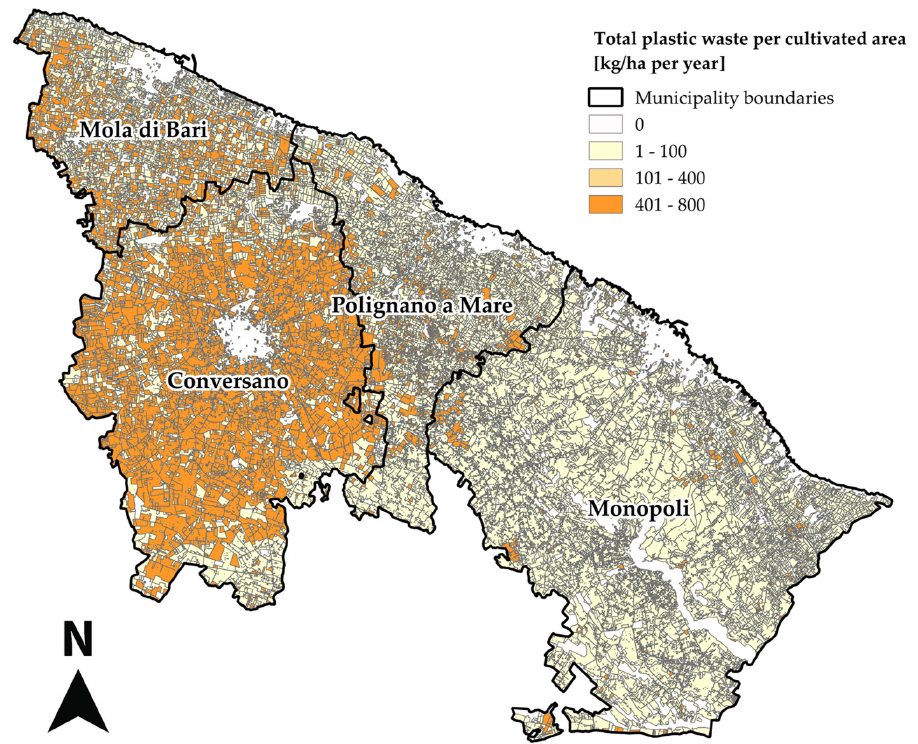
Figure 6. Distribution of the total APW in the four municipalities in the case of combination of the two improved scenarios (scenario comb).